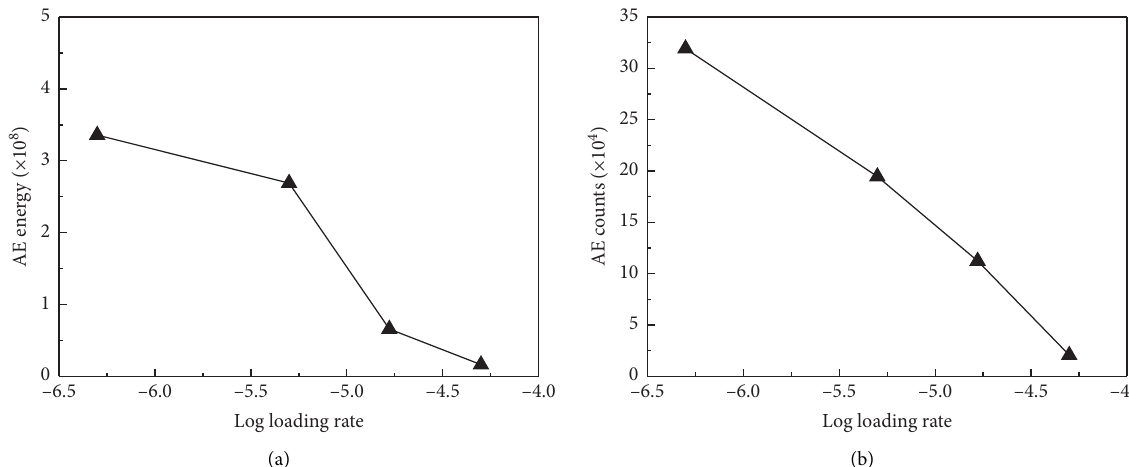
Figure 6: The cumulative AE energy and counts curves under different loading rates: (a) the relationship between AE energy and loading rate; (b) the relationship between AE counts and loading